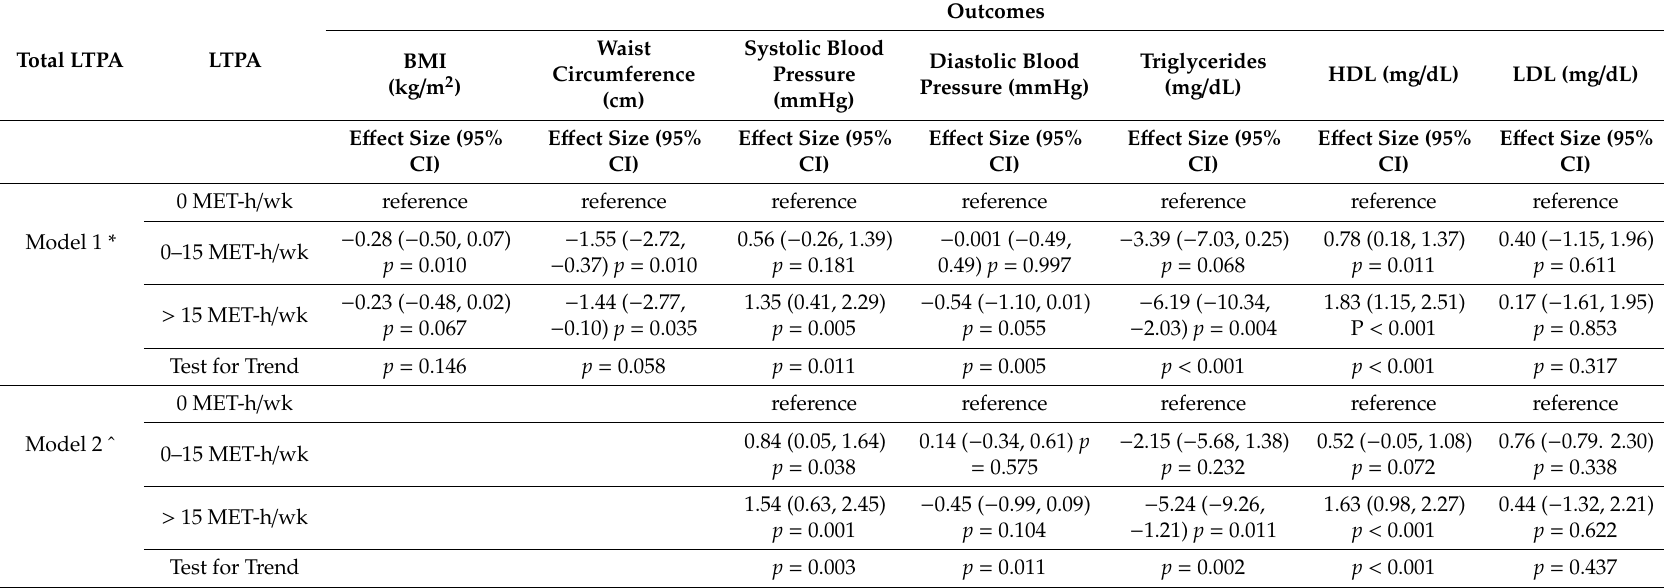
Table 2. Association between cardiometabolic measures and total leisure time physical activity